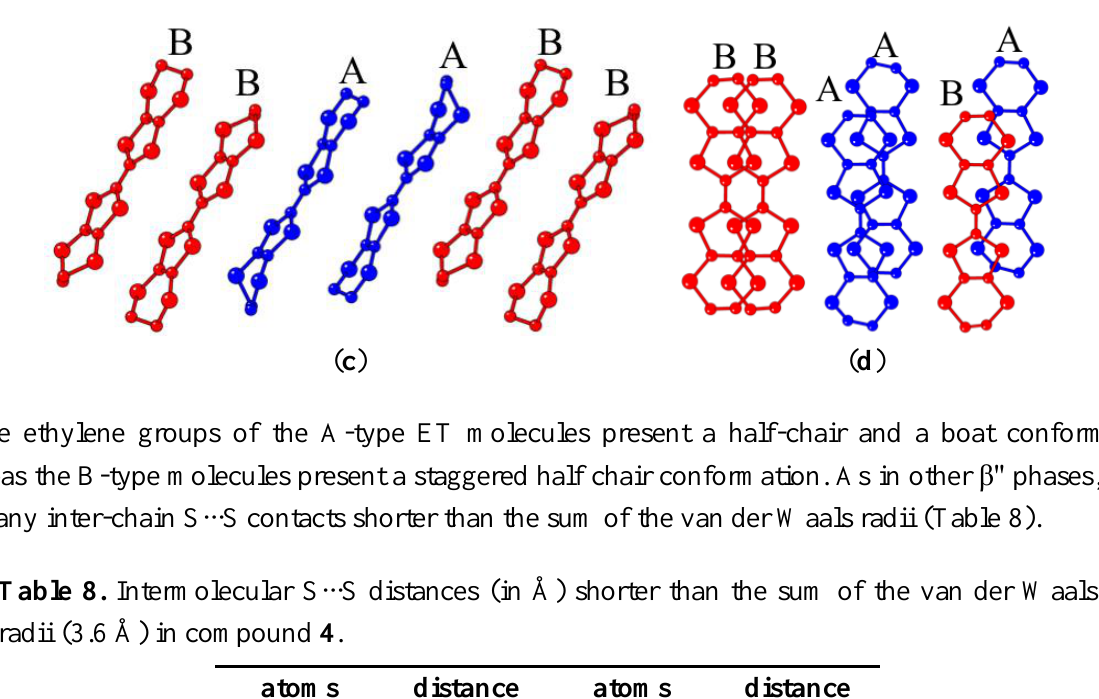
Table 9. Crystal data for compound β''-ET